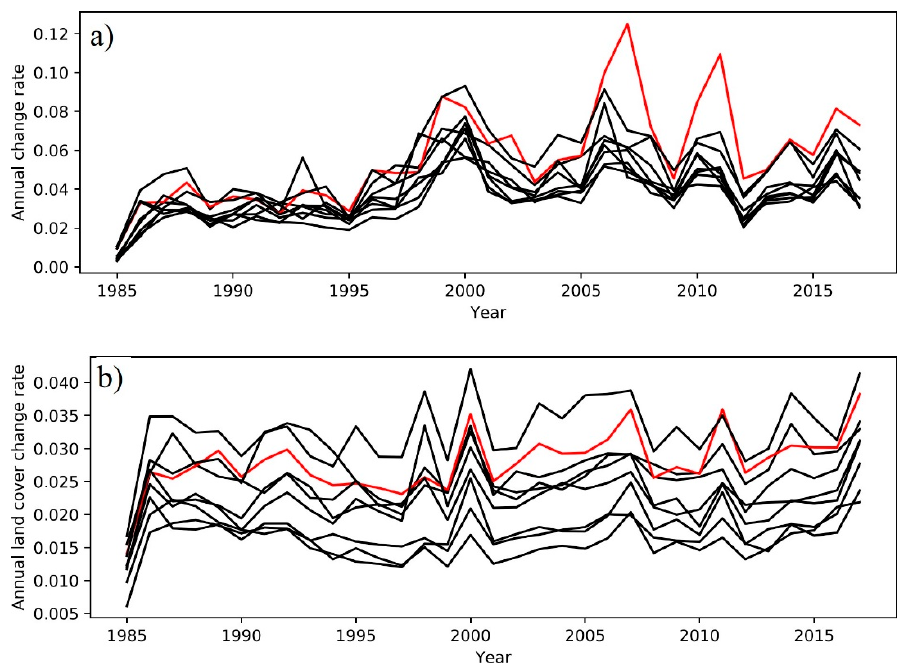
Figure 7. The (a) annual change rate and (b) annual land cover change rate of H25V15 (red line) Figure 7. The ( a ) annual change rate and ( b ) annual land cover change rate of H25V15 (red line) compared to the neighboring tiles (black lines). compared to the neighboring tiles (black